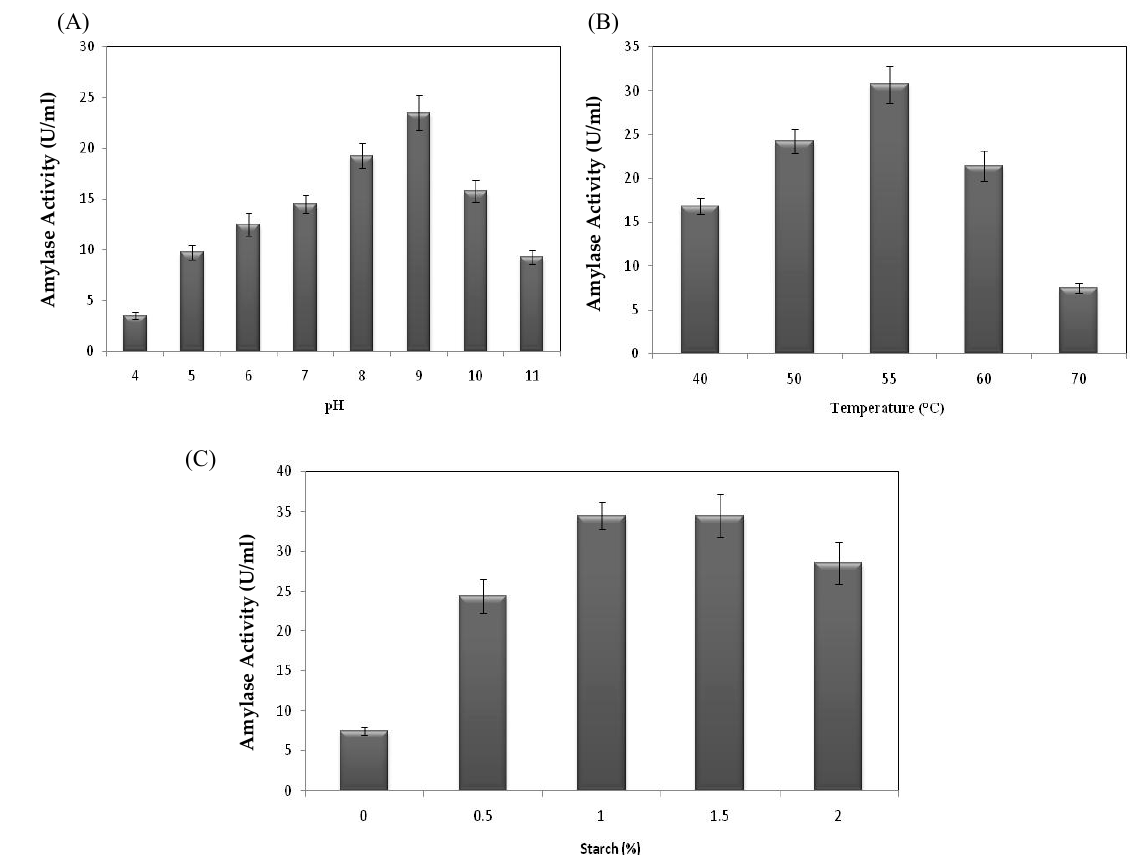
Figure 3. Effect of initial pH, temperature and substrate concentration on bacterial amylase activity. ( A ): Effect of initial pH on amylase production at 37 °C for 24 h in TSB medium. The experiments were performed in triplicate. Error bars are shown for the standard deviation. ( B ): Influence of the fermentation temperature on amylase productivity on TSB and at pH 9.0 for 24 h. The experiments were performed in triplicate. Error bars are shown for the standard deviation. ( C ): Effect of starch concentration (0–2%) on amylase activity from Bacillus pacificus when incubated in a shaking incubator at 55 °C, initial pH of 9.0 for 24 h. The experiments were performed in triplicate.